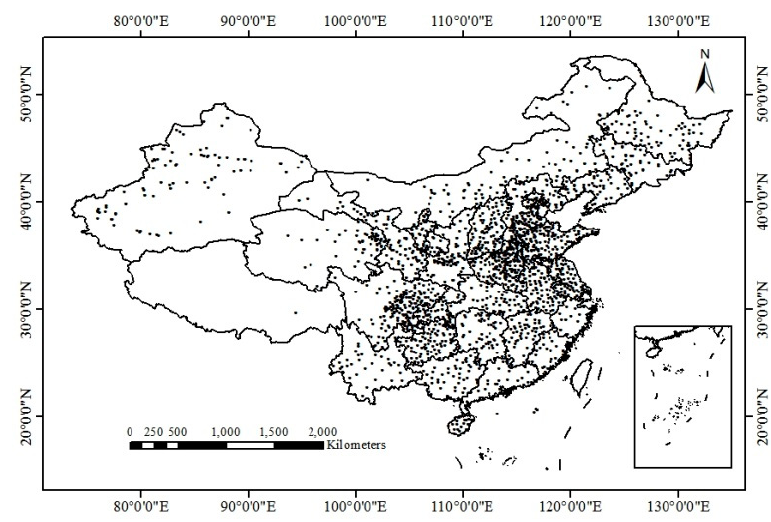
Figure 2. The distribution of in situ LST measurement stations in China.